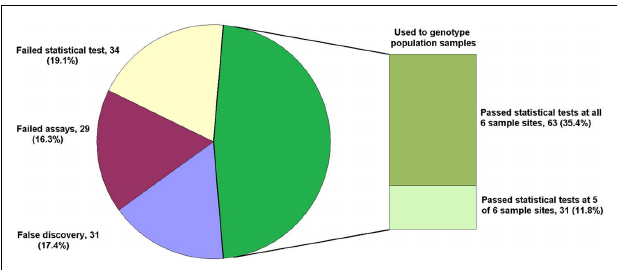
FIGURE 1 | Fate of 178 SNP marker assays. The total number of assays (percentage of the whole) are given for each category: False discovery (monomorphic in all samples), Failed assays (no nucleotide signal from Sequenom MassARRAY ® ), Failed statistical test (Hardy–Weinberg Equilibrium, HWE), and those used for genotyping population samples passing HWE tests in all instances and passing HWE tests in all but one